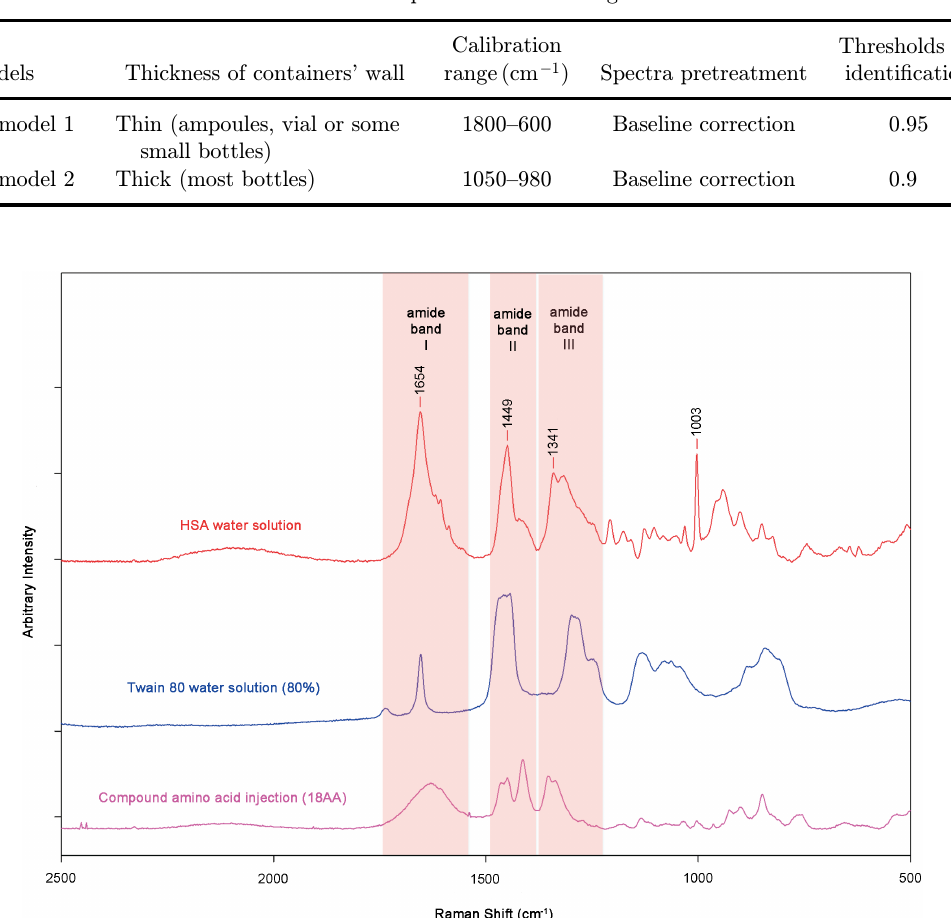
Fig. 2. Characteristic bands and peak of HSA spectrum comparing with spectra of twain 80 water solution and compound amino acid injection